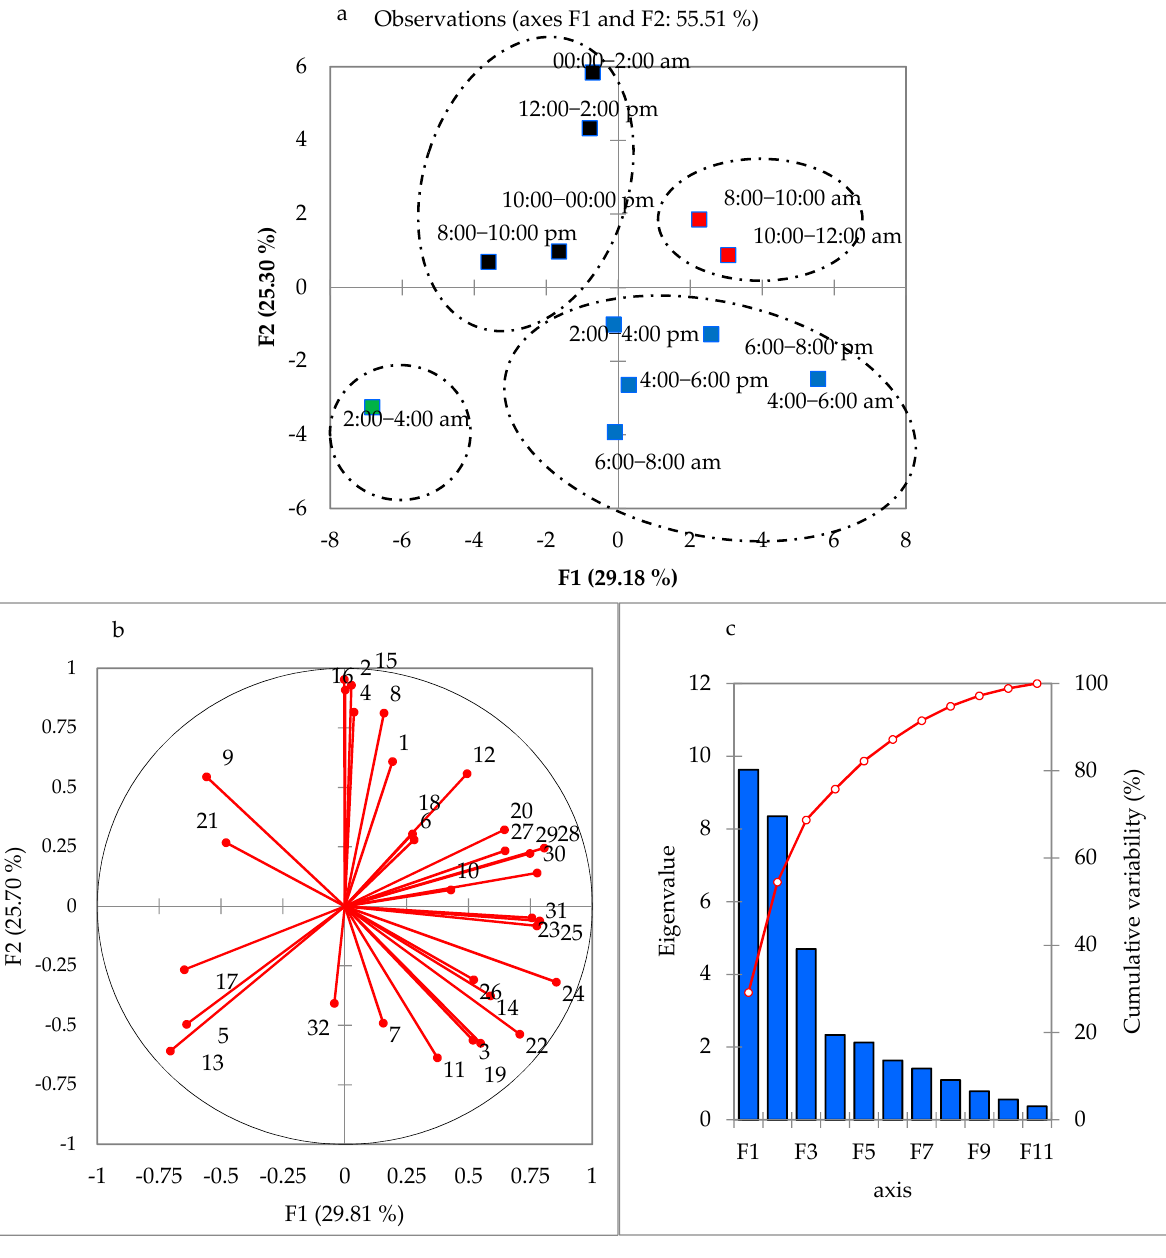
Figure 5. Biplot based on the first and second principal components (PC) during the day and night of S. officinalis. ( a ) Grouping of different treatments studied based on the first and second components. ( b ) Grouping of phytochemical compounds obtained from essential oils according to their first and second components and ( c ) Scree plot obtained by principal components analysis, which represents the eigenvalue values of each component. The compounds codes are reported in Table 2.